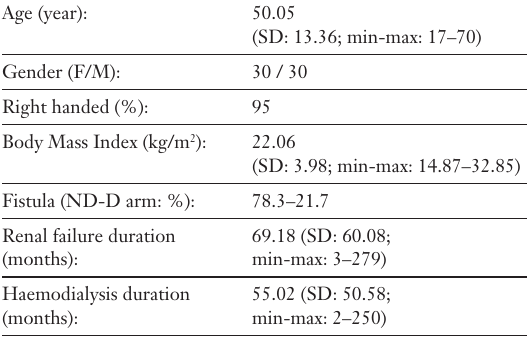
Demographic and clinical characteris- tics of subjects (n = 60).